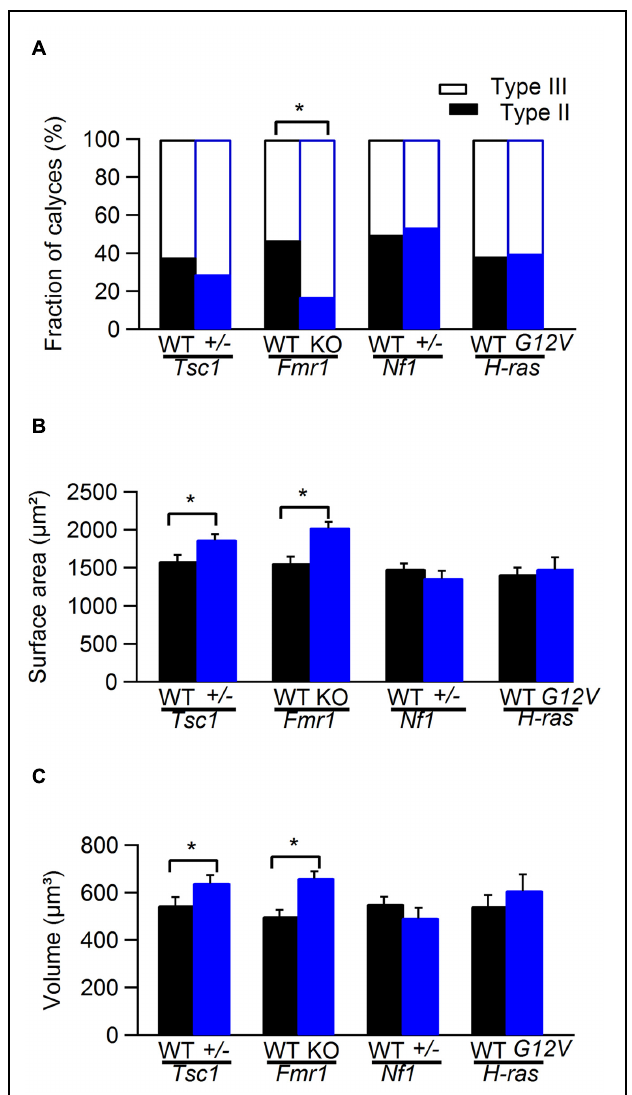
FIGURE 2 | Comparison of calyx of Held morphology from WT and mutant mice. (A) Comparison of the fraction of type II and type III calyces in WT (black) and Tsc1 + / − , Fmr1 KO, Nf1 + / − , and H-ras G 12 V mutant mice (blue). (B) Comparison of the surface area of calyx of Held synapse in WT (black) and Tsc1 + / − , Fmr1 KO, Nf1 + / − , and H-ras G 12 V mutant mice (blue). (C) Comparison of the volume of calyx of Held synapse in WT (black) and Tsc1 + / − , Fmr1 KO, Nf1 + / − , and H-ras G 12 V mutant mice (blue). ∗ indicates significant difference. Error bars indicate SEM.